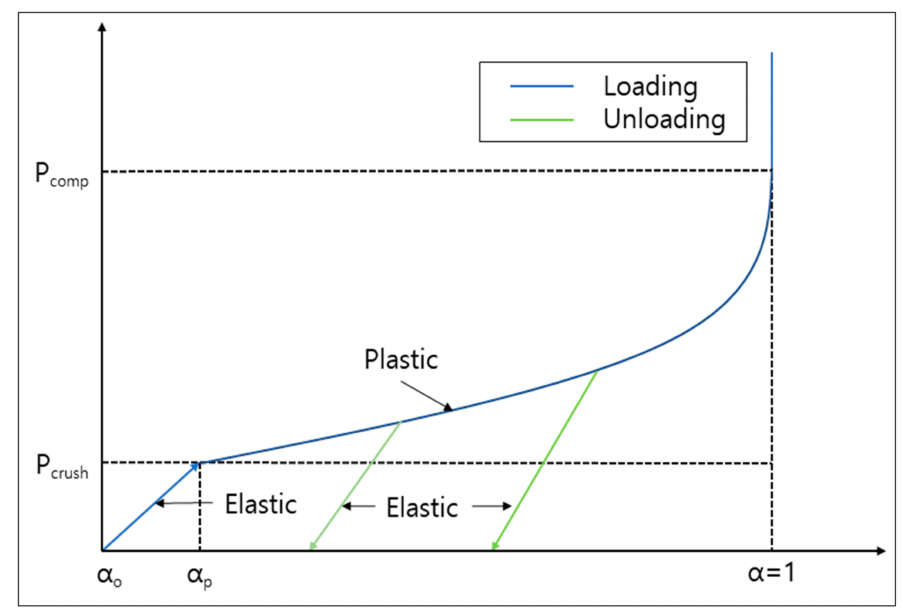
Figure 3. Schematic description of the p- α equation of state [Herrmann, W. et al.,